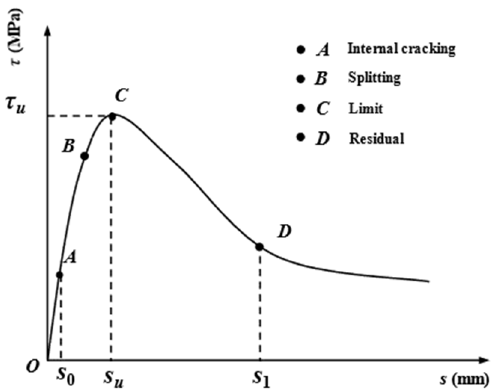
Figure 9. Bond–slip curves of